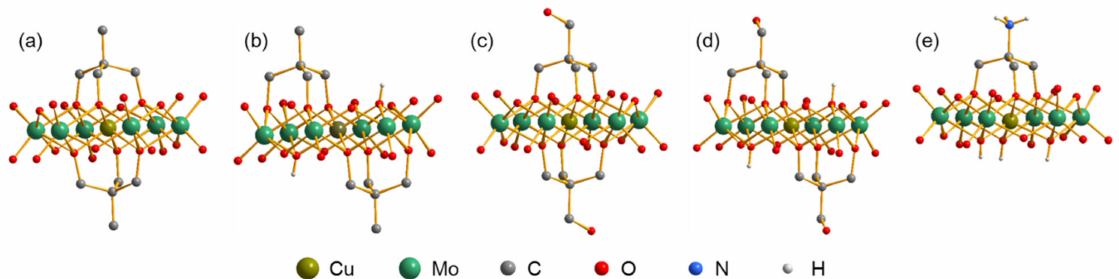
Figure 1. Polyanionic structures of compounds ( a ) 1 , ( b ) 2 , ( c ) 3 , ( d ) 4 , and ( e ) 5 in ball-and-stick representation. All H atoms except those attaching to N and µ 3 -O atoms are omitted for